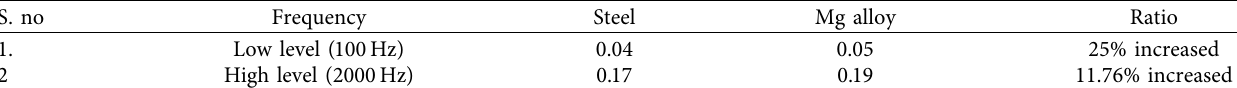
Table 13: Sound absorption coefficient ( α ) for both materials.